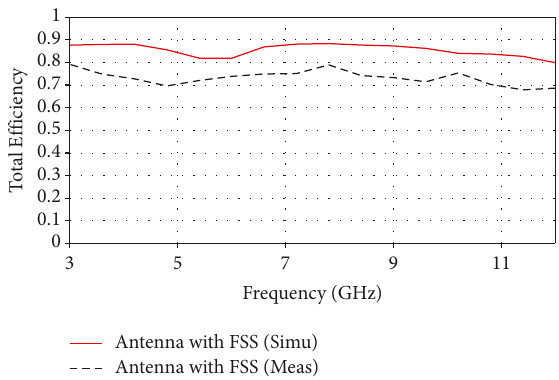
Figure 12: Total efficiencies of proposed antenna with FSS. Table 3: Comparison of FSS-based antenna with previous work. Ref